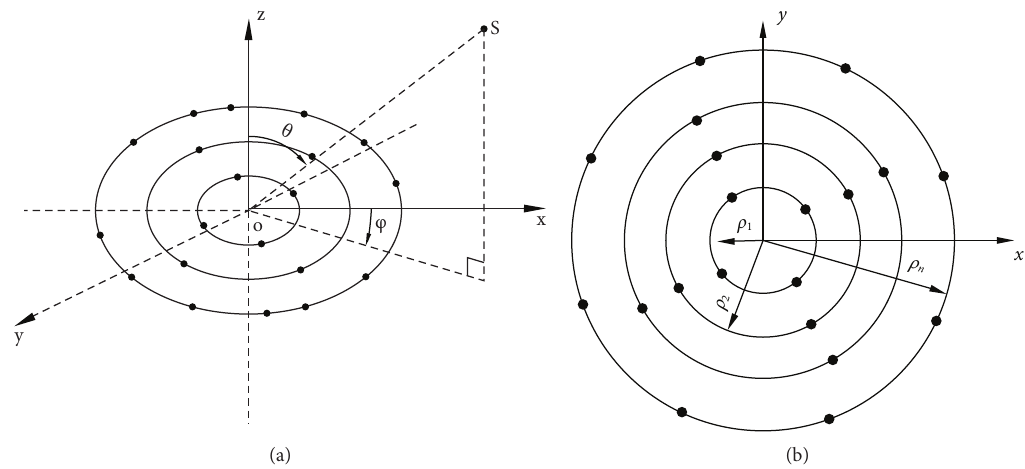
Figure 2: Geometry of a coaxial ring array and grid points: (a) isometric view; (b) top